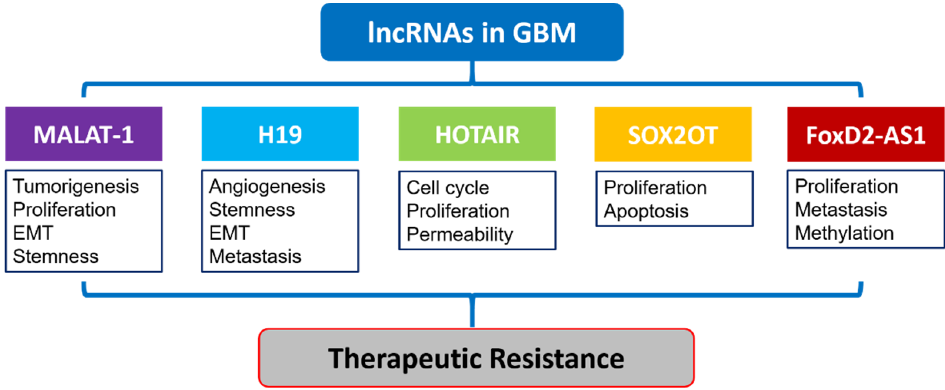
Figure 4. Schematic summary of several important lncRNAs in therapeutic resistance of GBM. The lncRNAs MALAT-1. H19, HOTAIR, SOXOT, and FoxD2-AS1 are involved in the therapeutic resistance of GBM through different mechanisms including tumorigenesis, proliferation, EMT, angiogenesis, stemness, metastasis, cell cycle, and apoptosis.